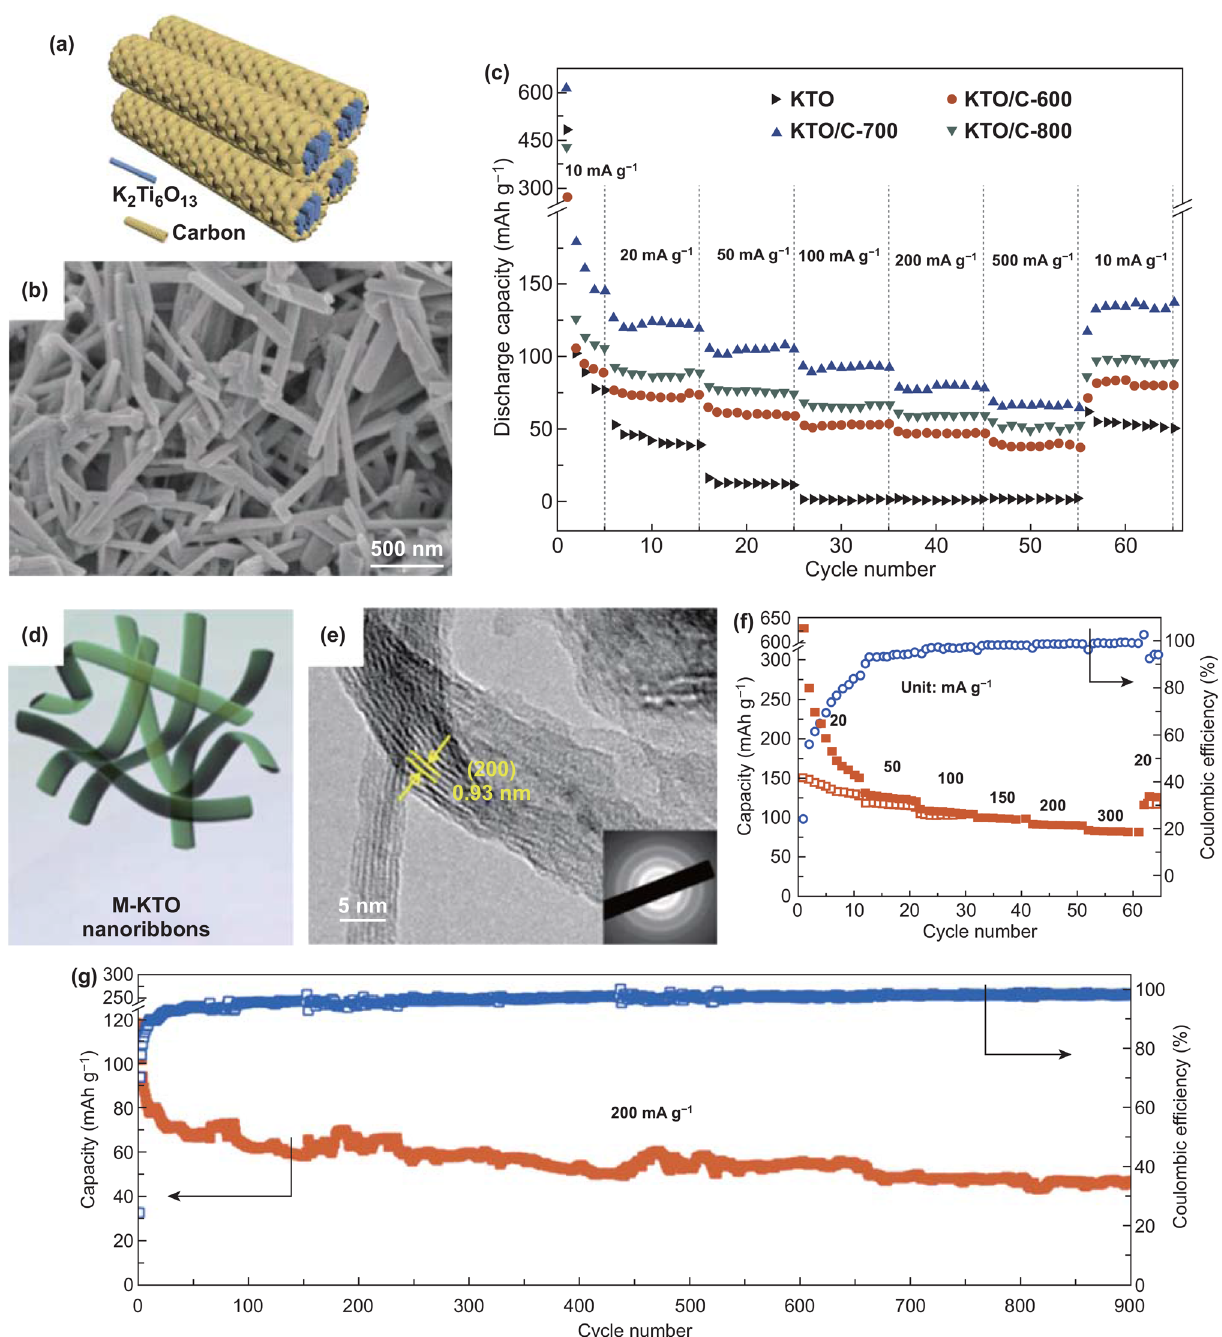
Fig. 7 a Schematic diagram of KTO/C. b SEM image of KTO/C-700. c Rate capacities of the obtained hybrids electrode. Reproduced with permission from Ref. [140]. Copyright 2020, Royal Society of Chemistry. d M-KTO nanoribbons’ schematic illustration. e M-KTO’s HRTEM image with the corresponding SAED patterns (inset). f M-KTO’s rate performance. g Long cycle capacities as well as C.E. of the obtained sam- ple at 200 mA g −1 . Reproduced with permission from Ref. [92]. Copyright 2017, American Chemical